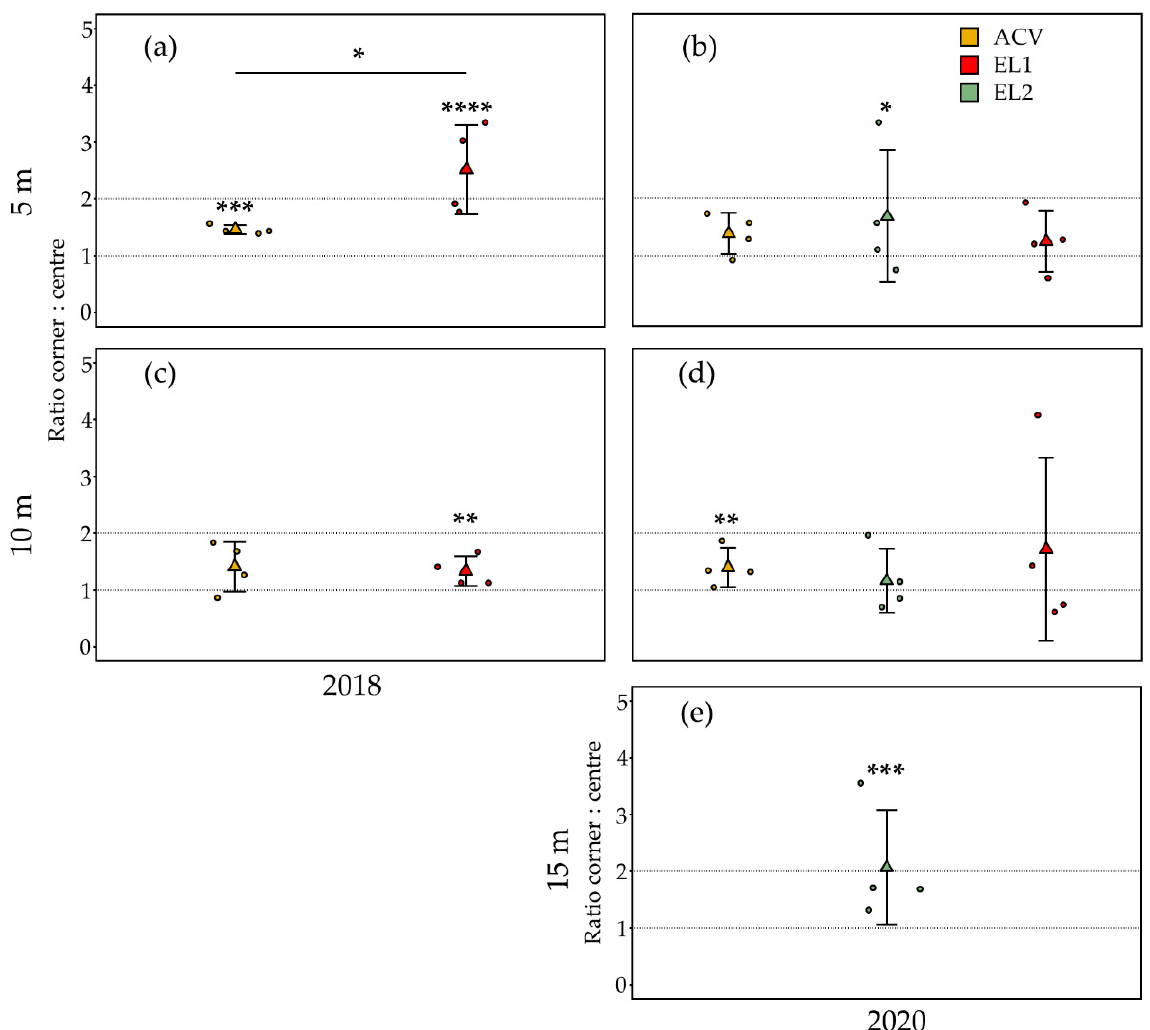
Figure 2. Corner to centre trap catch ( D. suzukii ) ratios for the two and three attractants tested in summer 2018 and 2020, respectively. Trials were conducted at an inter-trap spacings of 5 and 10 m, for EL2 15 m was tested as well. Jittered points represent the ratio per replicate ( n = 4) grid, triangles depict their mean and error bars are standard deviations. Asterisks above graphs refer to the level of significance regarding the difference in counts between corner and centre traps ( n = 16) analysed for each attractant and period (GLMM, * p ≤ 0.05, ** p ≤ 0.01, *** p ≤ 0.001, **** p ≤ 0.0001). Between